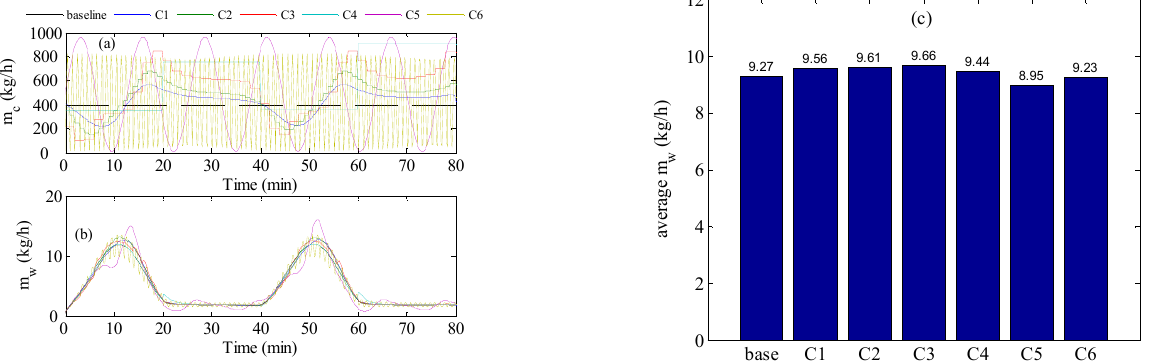
Figure 7. Optimal control result for inlet temperature varies as a sine-like wave; ( a ) cold stream flow rate, ( b ) mass production rate, ( c ) Time-averaged mass production; C1: T s = 20 s, C2: T s = 1 min, C3: T s = 2 min, C4: T s = 20 min, C5: sinusoidal. C6: squared sinusoidal.